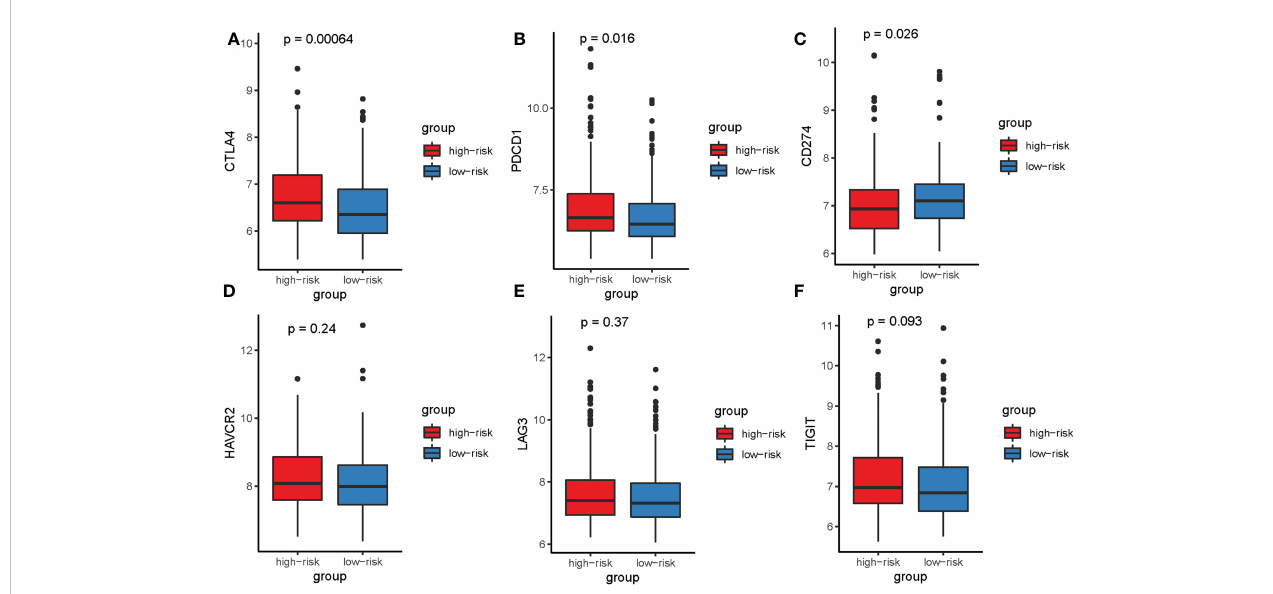
FIGURE 11 Box plots visualizing signi fi cantly different immune checkpoints between the high-risk and low-risk groups. (A) CTLA4; (B) PD1; (C) PD-L1; (D) TIM-3; (E) LAG3; (F)